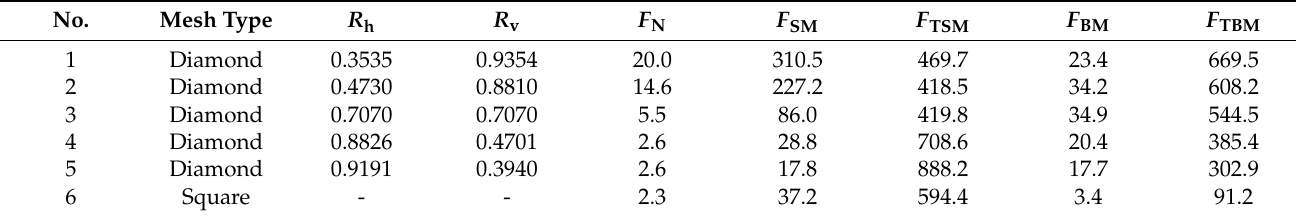
Table 2. Tension force on the trash-blocking nets for different hanging